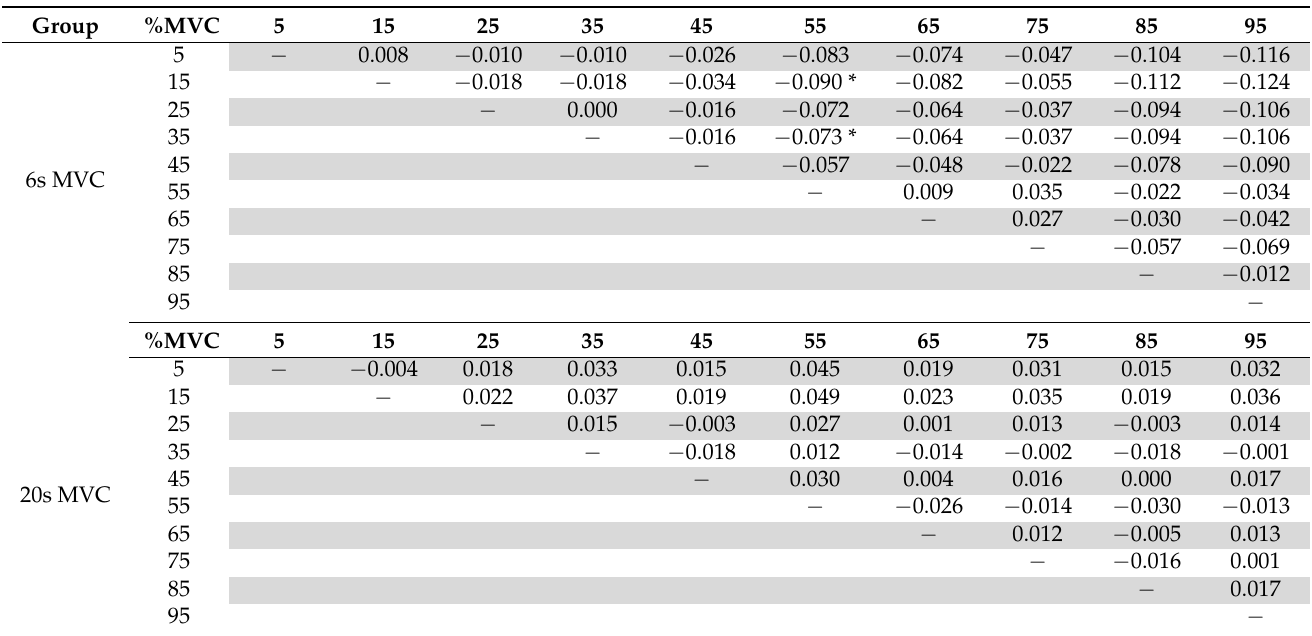
Table 5. Mean Differences in DFA ( α ).